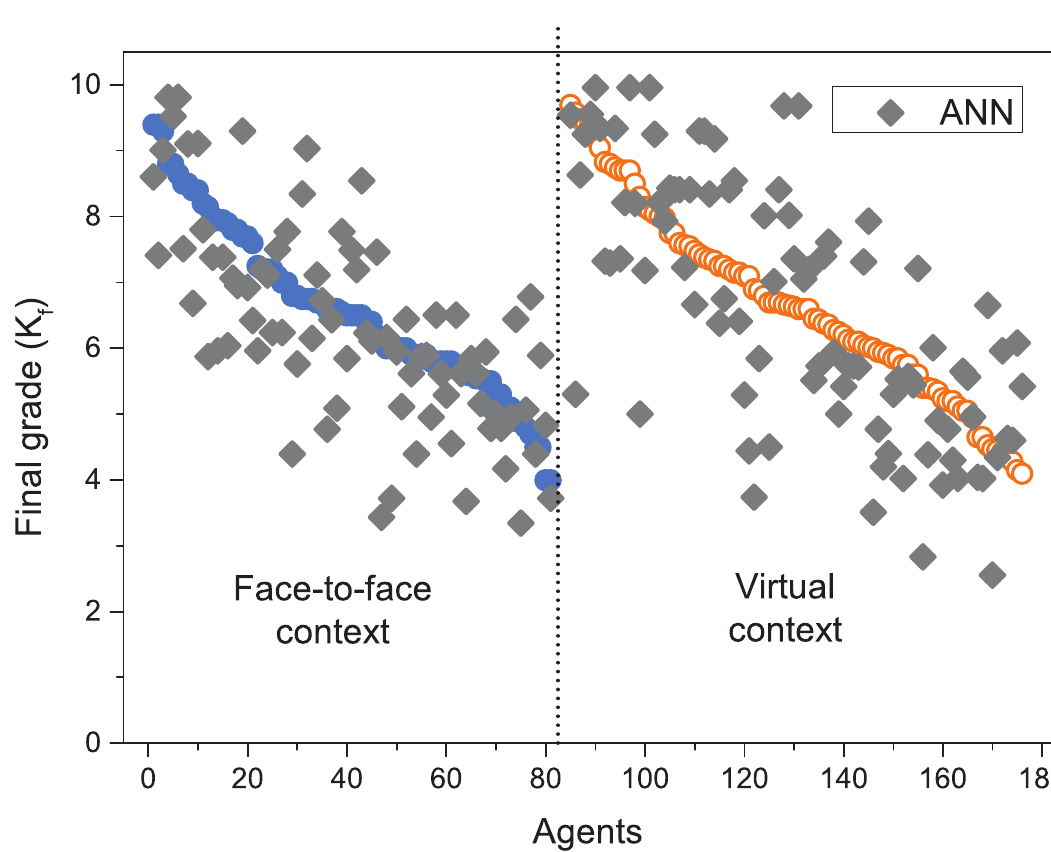
Fig 6. Final knowledge comparison between the actual final grade obtained for each student in both contexts (circles) and the KA Model of Eq 1 using the coefficients obtained with the ANN approach (diamonds).